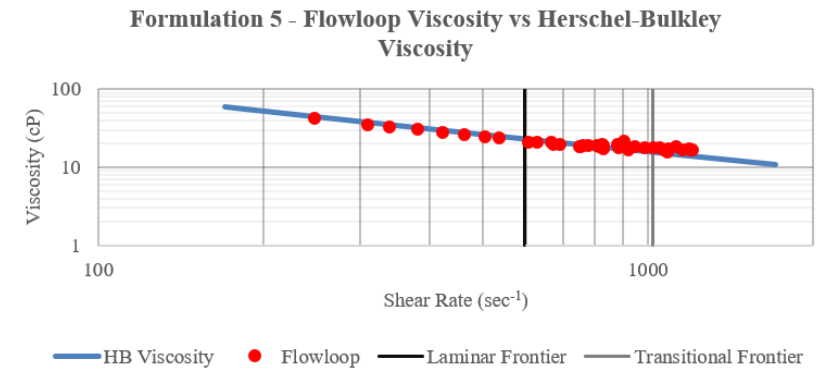
Figure 14: Formulation 4 - Flowloop Viscosity vs Herschel-Bulkley Viscosity